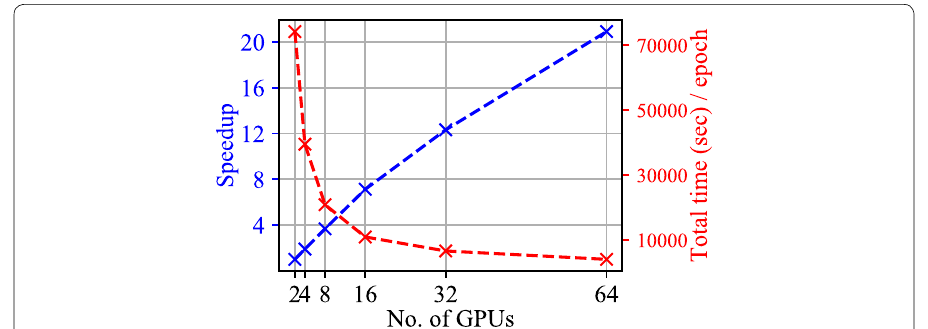
Fig. 1 ImageNet ResNet-50 training Global throughput (images/sec) and speed up obtained by scaling the training of ResNet-50 using the ImageNet dataset. The training stage is reduced to just over 1 hour, achieving 93% accuracy, using the entire HAL cluster